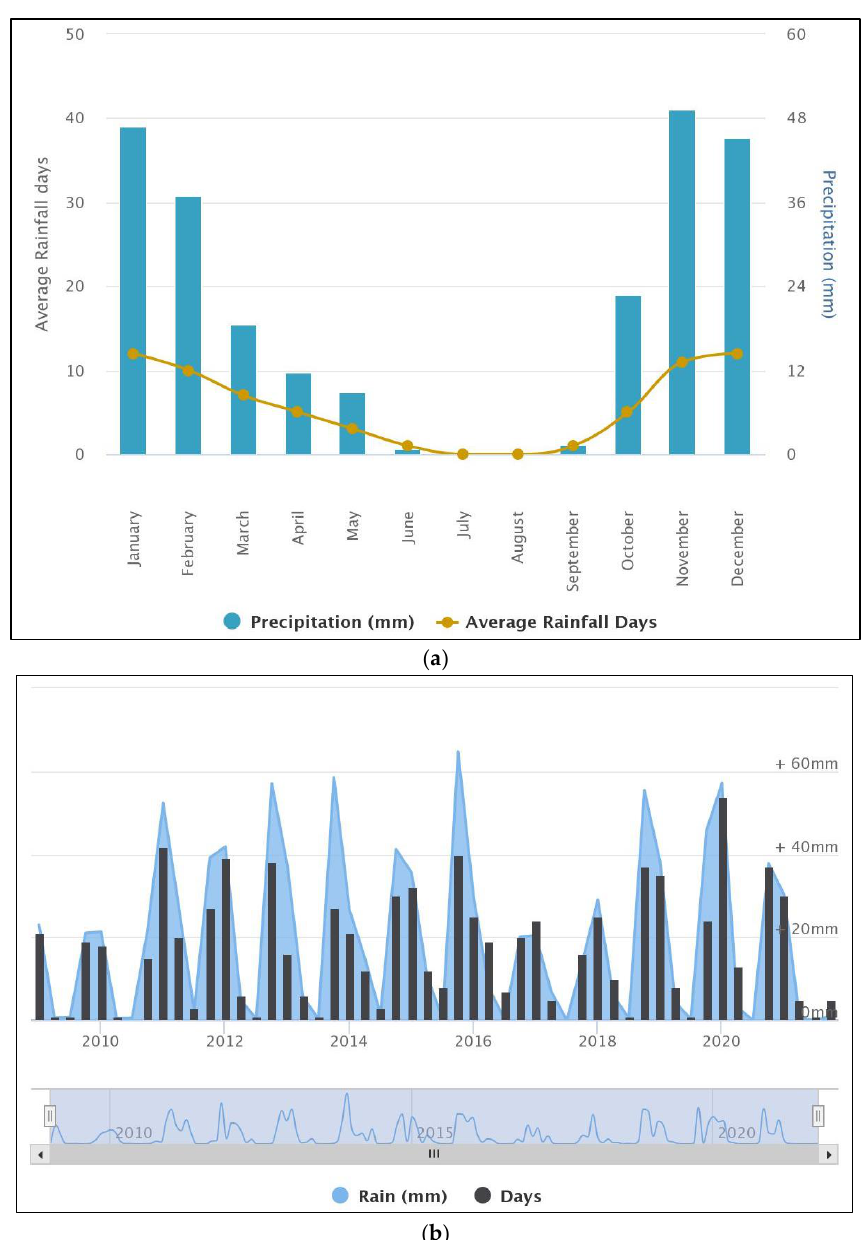
Figure 2. ( a ) Monthly average rainfall. ( b ) Average annual rainfall amount (mm) and rainy days during the period 2009–2021 for Port Said